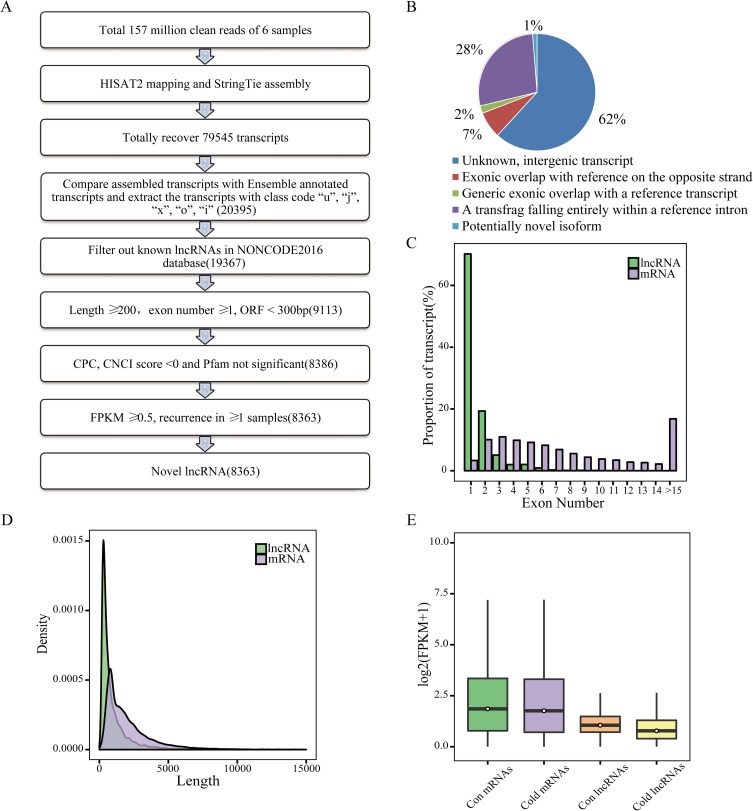
Identification and characterization of lncRNAs.(A) Workflow for identification of lncRNAs. The value in parentheses shows the number of transcripts. (B) Distribution of lncRNA in different chromosomal regions. (C-E) Comparison of exon numbers, transcript lengths, and expression levels between mRNAs and novel lncRNAs. Con: control cells; cold: cold acclimated cells.